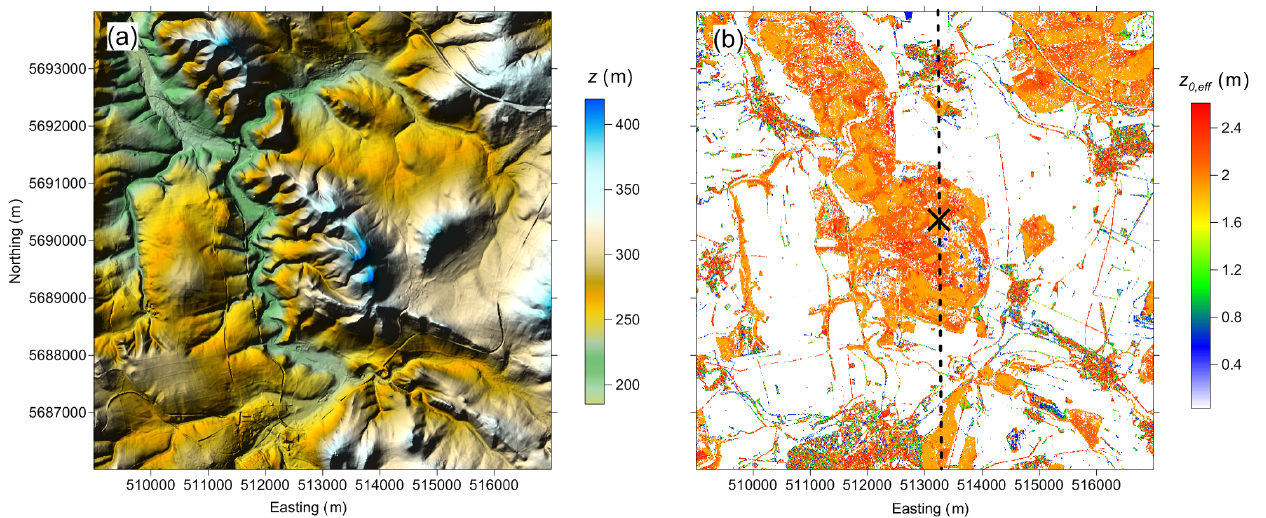
Figure 3. (a) Shaded relief plot of the elevation, and (b) horizontal distribution of modelled effective roughness, z 0 , eff , at Rödeser Berg. Elevation map was produced using data derived by Freier (2017) from ALS data set available from the Hessian Administration Office of Land Management and Geological Information (HVBG, 2010). The calculation resolution is 10m × 10m. Cross indicates the location of measuring tower. Dashed line indicates transect used for modelling results presented in Fig.